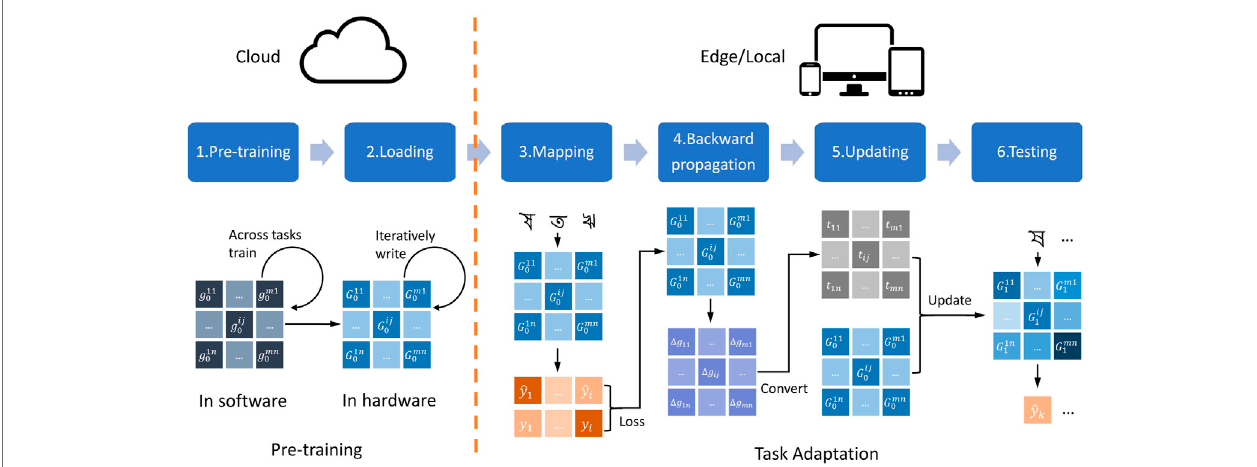
FIGURE1| TheframeworkofROA(RapidOne-stepAdaption).Inthepre-trainingphase: (1)wetrainagoodinitialnetworkacrosstaskswithparameters g ij 0 ;(2)we loaditintothememristorarrayas G ij 0 withiterativeprogrammingwithwrite-verify.Inthetaskadaptationphase:(3)wemapthetaskintovoltageinputofthememristorfor prediction ^ y i ,thenwecalculatethelossfunctionwithtruelabel y i ;(4)wecalculatethegradientdescent Δ g ij withlossbybackpropagation; (5)weconvert Δ g ij intoupdate pulse period t ij and update the hardware network; (6) we evaluate the network on the testing dataset. The color and its brightness of the matrix indicate different forms of data and its